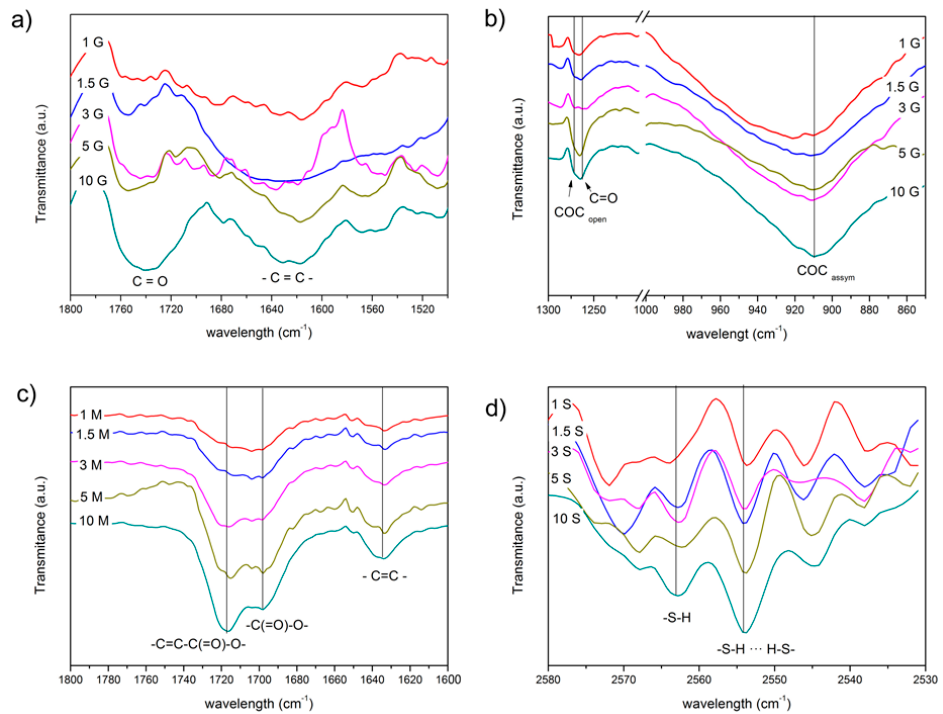
Figure 3. Detailed regions of the FTIR spectrum of the mesoporous materials functionalized with ( a , b ) GLYMO, ( c ) MEMO, and ( d ) MPTMS silane at different concentrations.